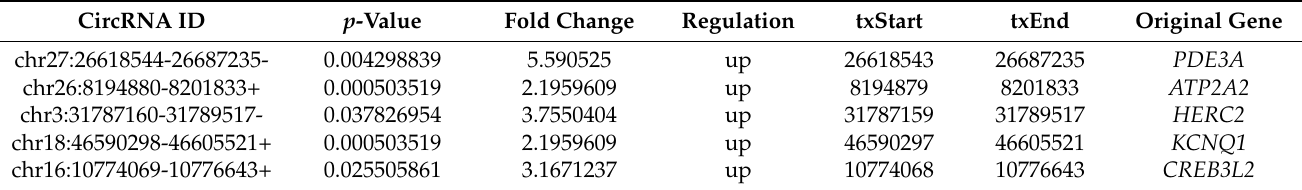
Figure 2. ( A ) Volcano plot filtering. The red area represents differentially expressed circRNAs with fold change > 2, p < 0.05; ( B ) scatter plots. Red for high abundance, green for low abundance (fold change > 2, p < 0.05); ( C ) circRNA expression circos, outline is the reference genome, inside is the chromosome coverage across all the samples. Table 3. The 11 differentially expressed circRNAs that correlated with the occurrence of canine mammary